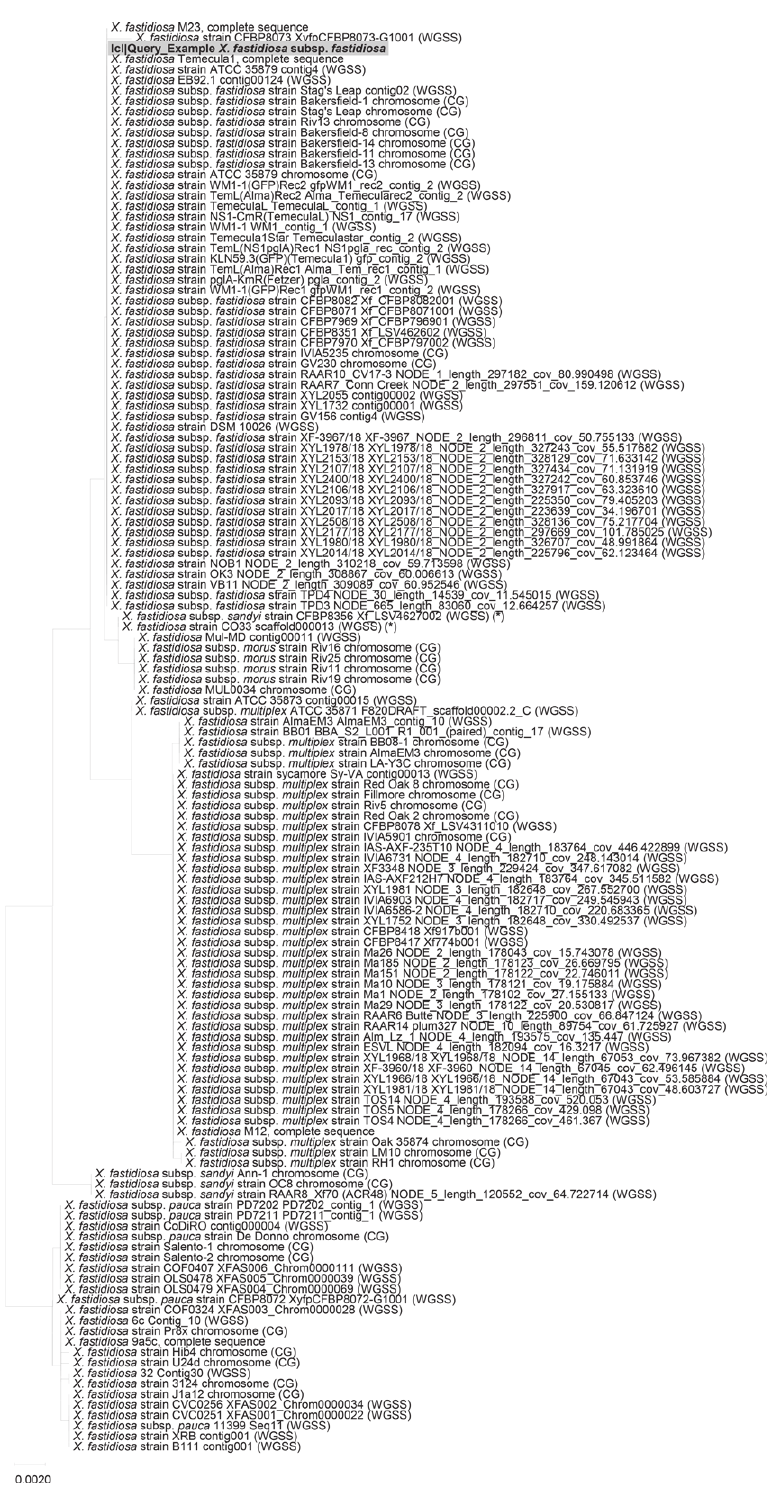
Figure 1. Phylogenetic distance tree of RNA polymerase sigma-factor 70 ( rpo D) partial sequences obtained after BLAST analysis (http:// www.ncbi.nlm.nih.gov/) of a query sequence against the RefSeq Genome database of Xylella fastidiosa (taxid: 2371). The different clusters correlate with main X. fastidiosa subspecies. lcl|Query= Represents an example of a query made for the rpo D sequence of a X. fastidiosa subsp. fastidiosa strain. (CG)= Complete Genome; (WGSS)= Whole Genome Shotgun Sequence. (*)= recombinant subspecies